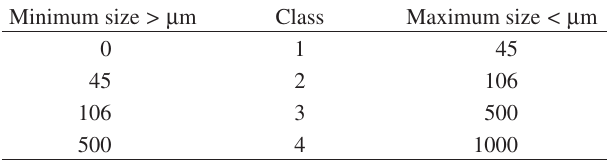
Table 1. Granite particles size and the classification adopted for PSs.